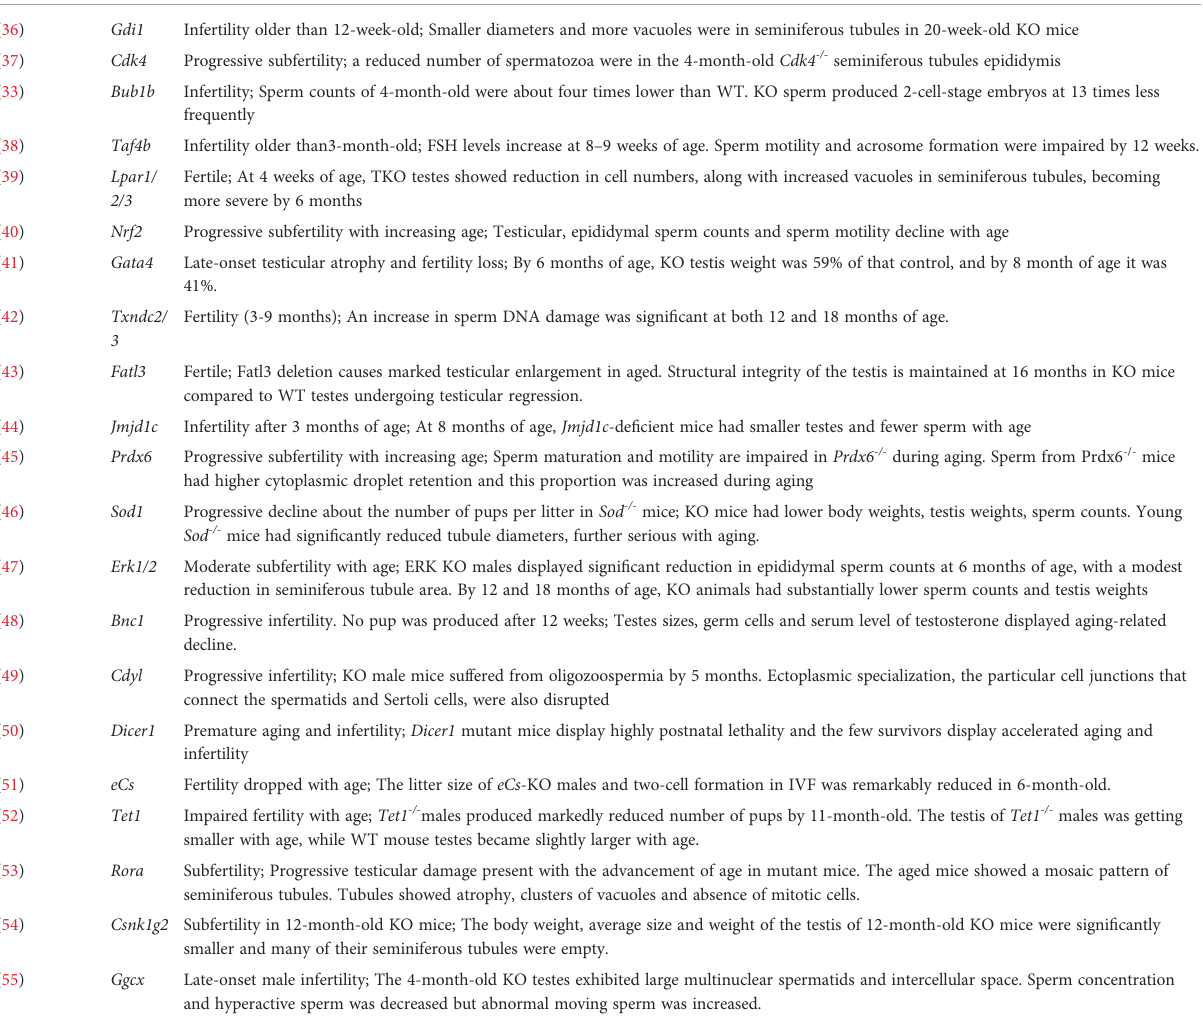
TABLE 1 The roles of reproductive senescence regulatory